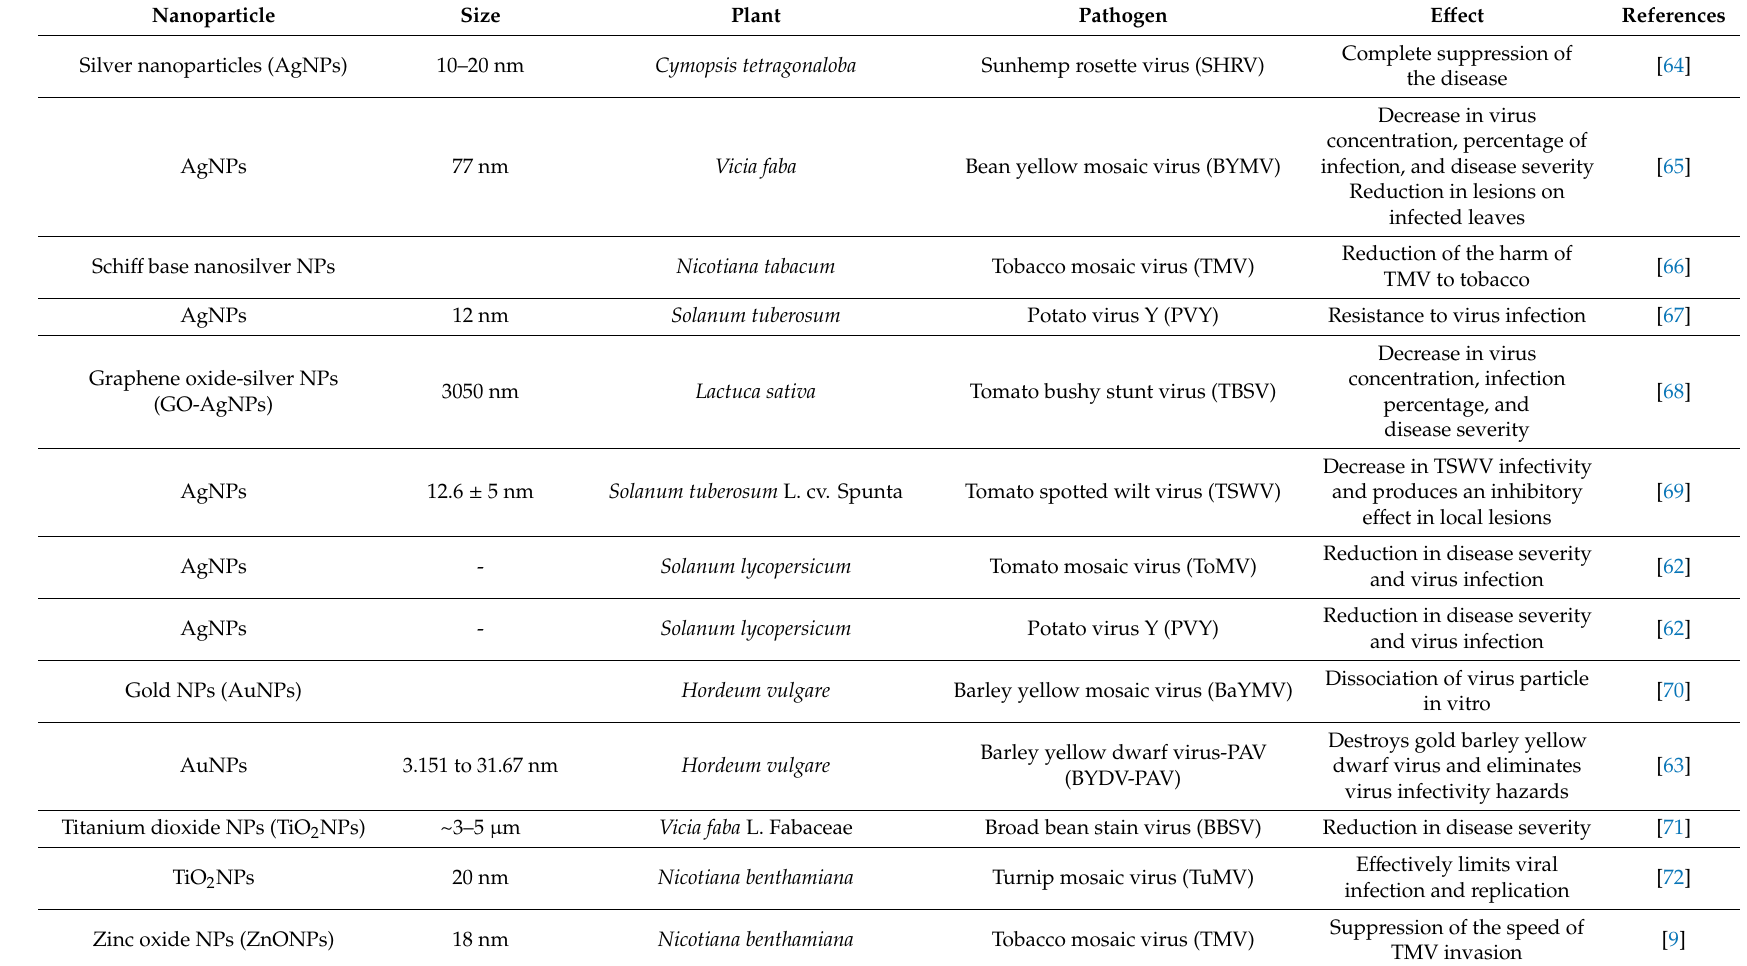
Table 1. Antiviral activity of metal and metal and metal oxide